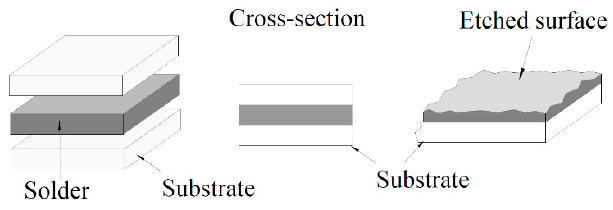
Figure 1. Schematic diagram of Sn-Zn/Ni(Cu) joints.